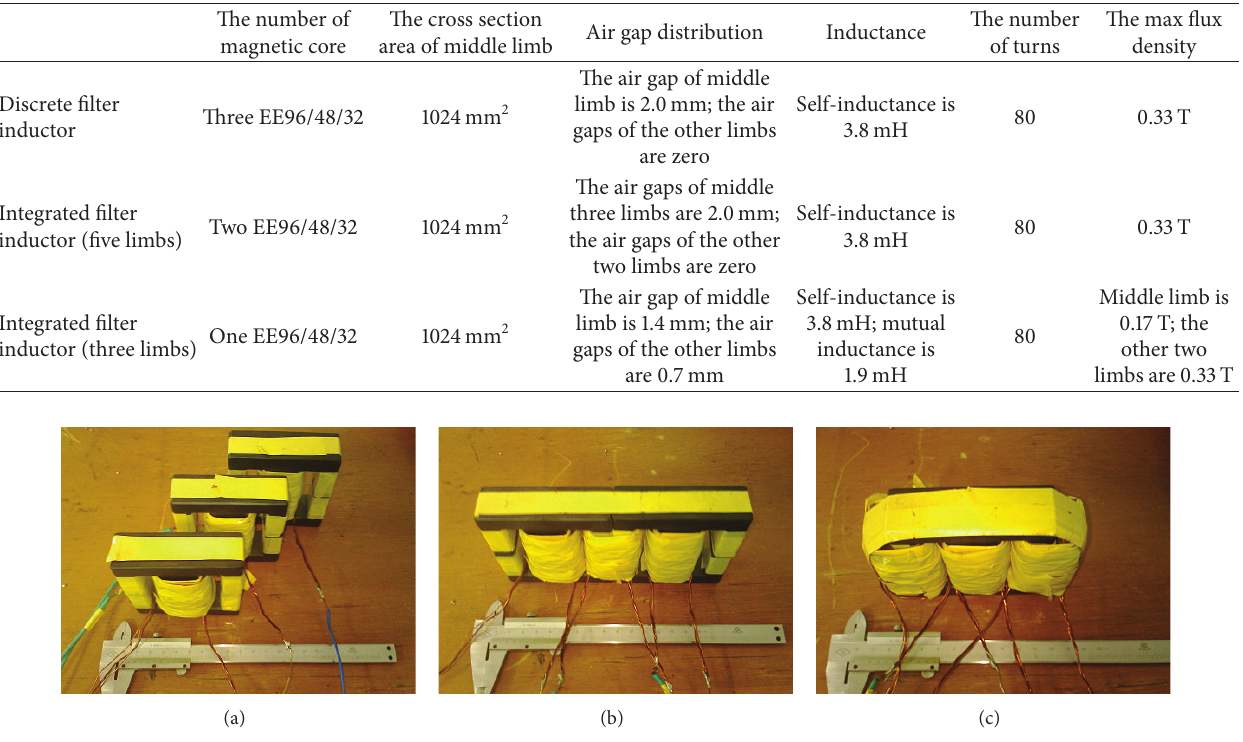
Figure 8: The comparison of discrete magnetics, five-limb magnetics, and three-limb magnetics: (a) discrete magnetic cores, (b) integrated magnetic core with five limbs, and (c) integrated magnetic core with three limbs.